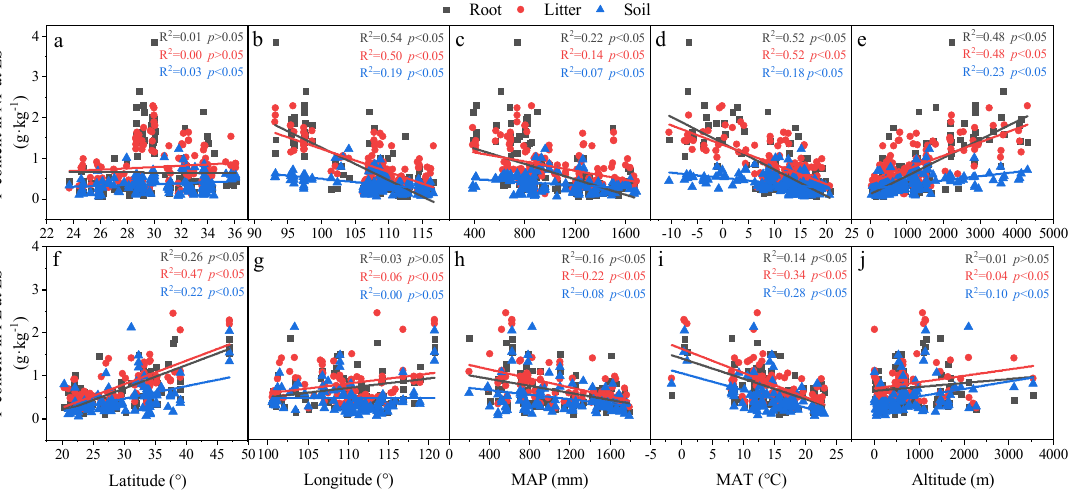
Figure 5. P concentration changes with latitude ( a , f ), longitude ( b , g ), mean annual precipitation (MAP) ( c , h ), mean annual temperature (MAT) ( d , i ) and altitude ( e , j ) in different forest origins in the early stage (ES). The numbers of forest sites are 149 and 102 for NF − ES and PL − ES, respectively.